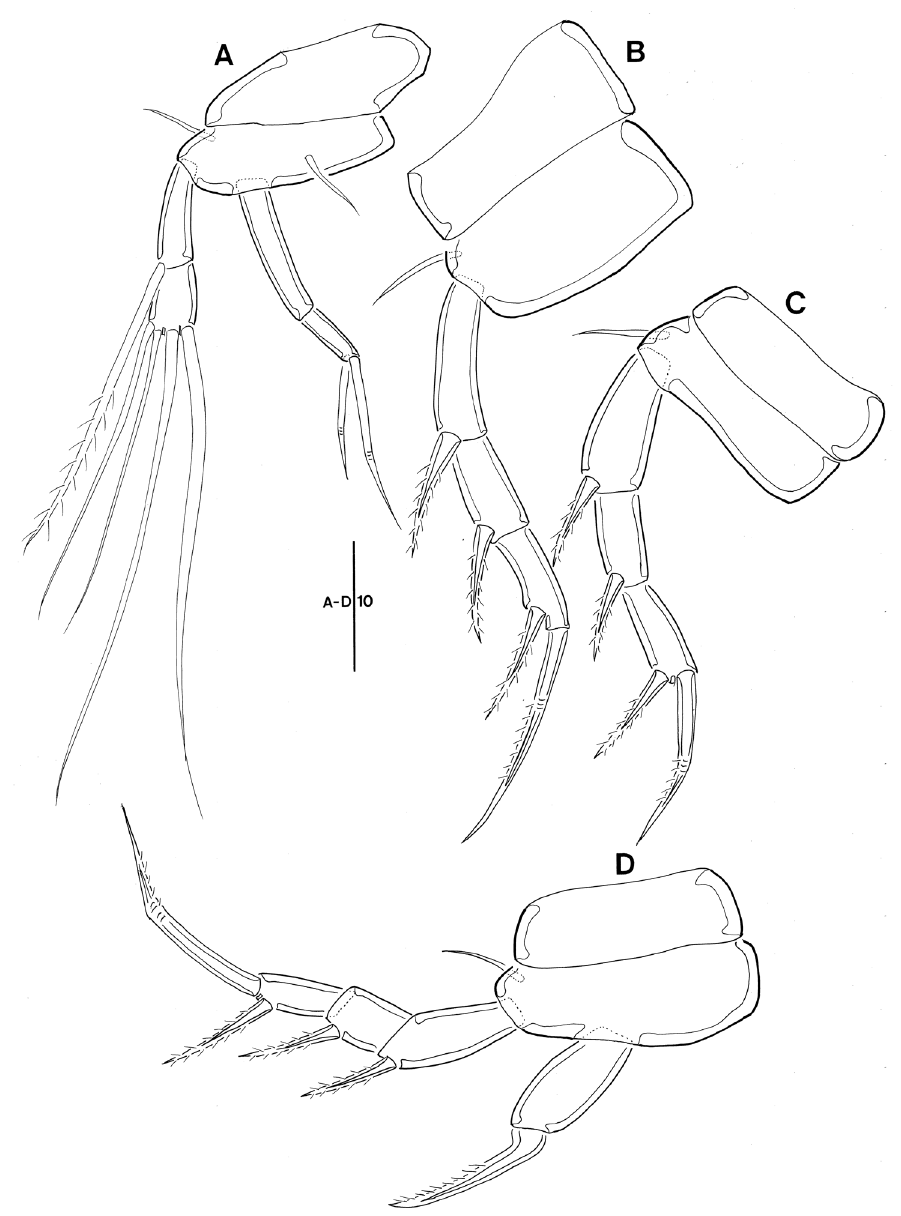
Figure 4. Leptopsyllus ( Leptopsyllus ) pundius sp. n. ( ♀ ). A P1 B P2 C P3 D P4. Scale bars are in microns.